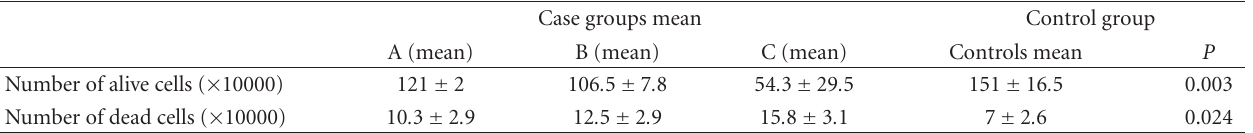
Table 1: The number of dead or alive cells in flasks with WEHI-164 fibrosarcoma cells following 48 hours of treatment with 10 (A), 50 (B), or 100 (C) hydatid cyst protoscolices (case groups) or left intact (control group) (mean of triplicate performance).